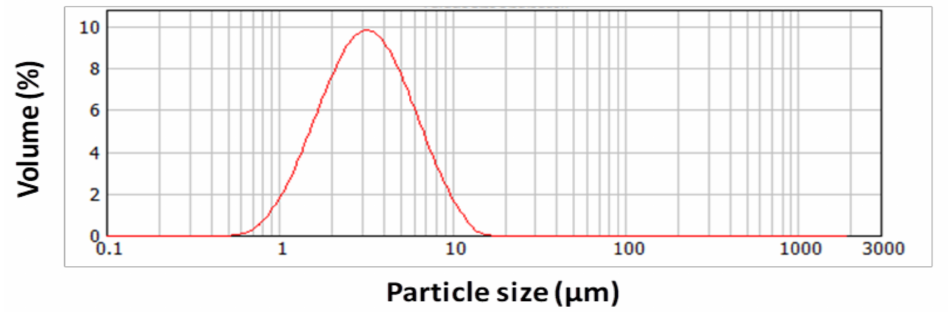
Figure 2. Particle size distribution of the as-received hydrophobic silica.